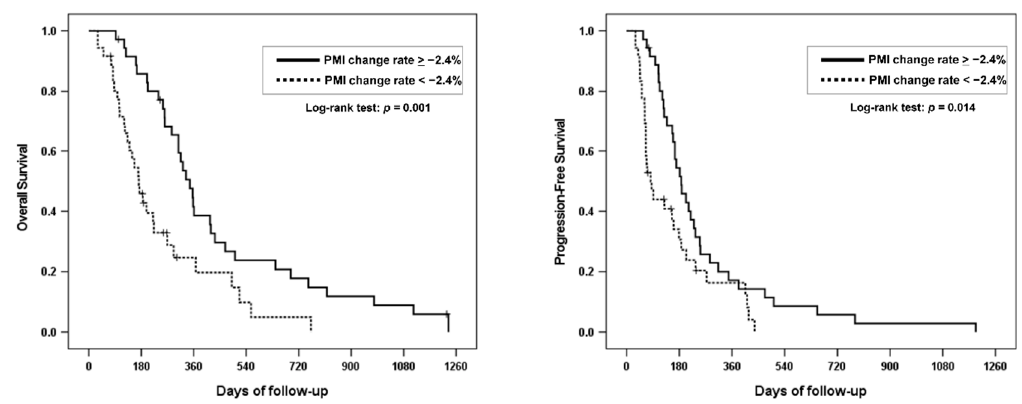
Figure 3. Overall survival and progression-free survival according to PMI change rate.